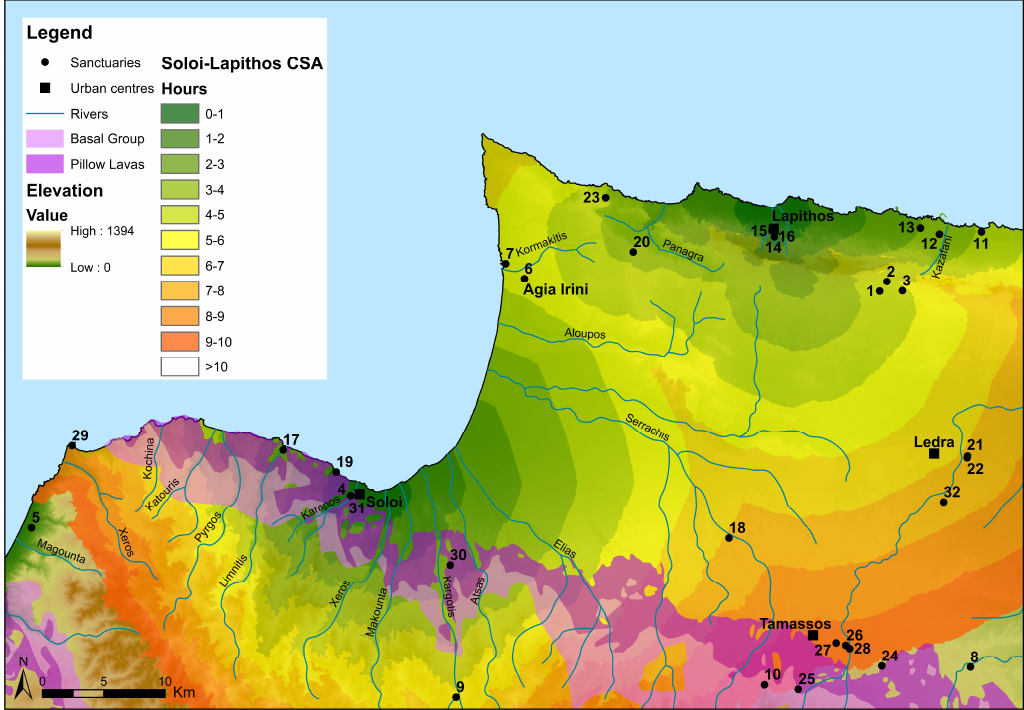
Figure 10. Cost Surface Analysis from Soloi and Lapithos; Digital data courtesy of the Geological Survey Department, Cyprus (by Charalambos Paraskeva).